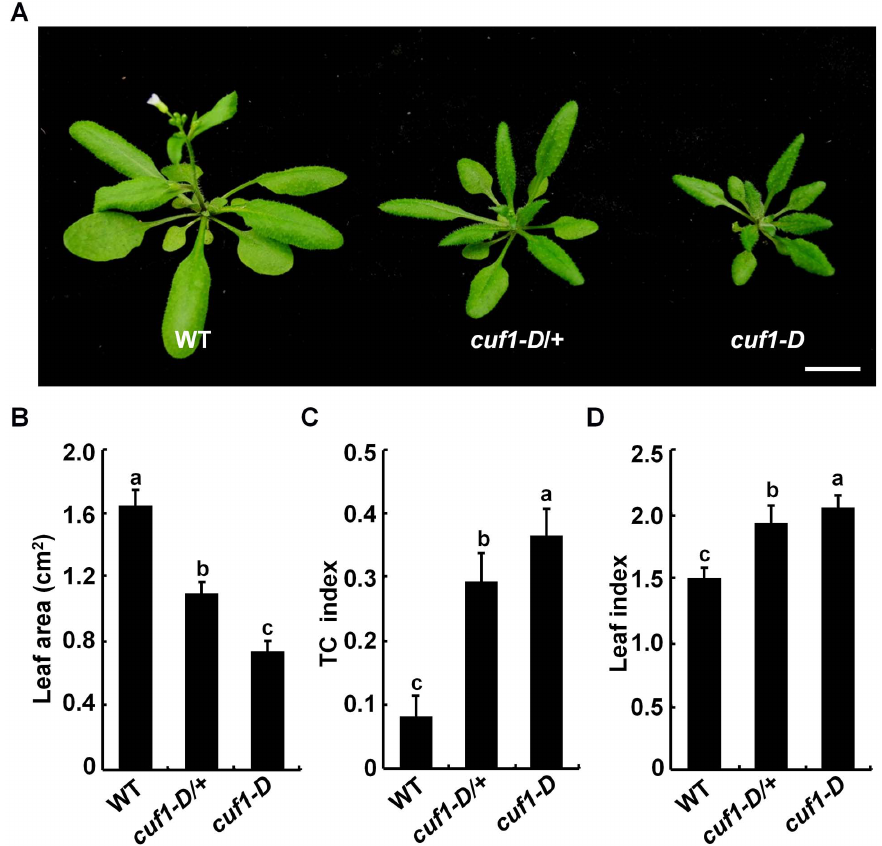
Figure 1. Phenotype of cuf1-D plants. (A) Morphology of 4-week-old wild-type (WT), cuf1-D/ + , and cuf1-D plants. The scale bar represents 1 cm. (B) Blade areas of WT, cuf1-D/ + , and cuf1-D leaves. (C) Transverse curvature (TC) index of WT, cuf1-D/ + , and cuf1-D leaves. (D) Leaf index (ratio of length to width) in WT, cuf1-D/ + , and cuf1-D plants. At least 10 sixth leaves from each genotype were used for determination of the leaf area, TC index, and leaf index as described in the methods section, respectively. Data are shown as mean values 6 one SD, and the letters (a to c) indicate the significance (P , 0.05) among the genotypes according to one-way ANOVA test (SPSS 13.0, Chicago, IL, USA).